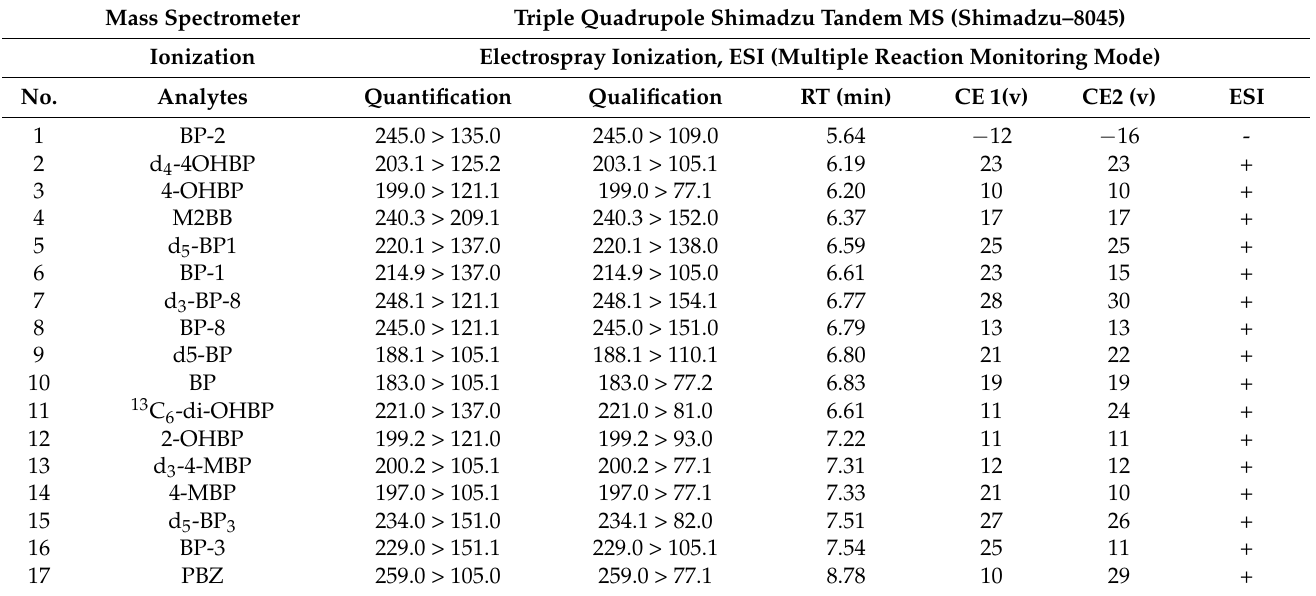
Table 1. Retention time and MS parameters for quantifying BP and BP analogs and